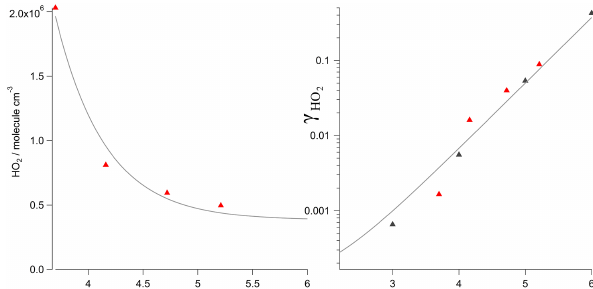
Figure 5. (a) Dependence of the HO 2 concentration observed in clouds as a function of cloud pH. All in-cloud HO 2 data were averaged into corresponding pH bins (0.6pH units). The [HO 2 ] decreases exponentially with increasing pH with the line of best fit ( [ HO 2 ]=3.8 × 10 5 +5.5 × 10 9 exp -2.2 pH ) displayed by the grey line. Figure 5b: the cloud uptake coefficient estimated by optimis- ing the HO 2 concentration calculated from the analytic expression of Carlsaw et al. (1999) compared to the observed HO 2 concentra- tion as a function of pH (red triangles). The theoretical expression derived by Thornton et al. (2008) (Eq. 4) using parameters provided in Table 2 is shown as the black triangles with the grey line being a best-fit line for these data ( γ HO =2.15 × 10 − 6 exp 2.01 pH ) 2